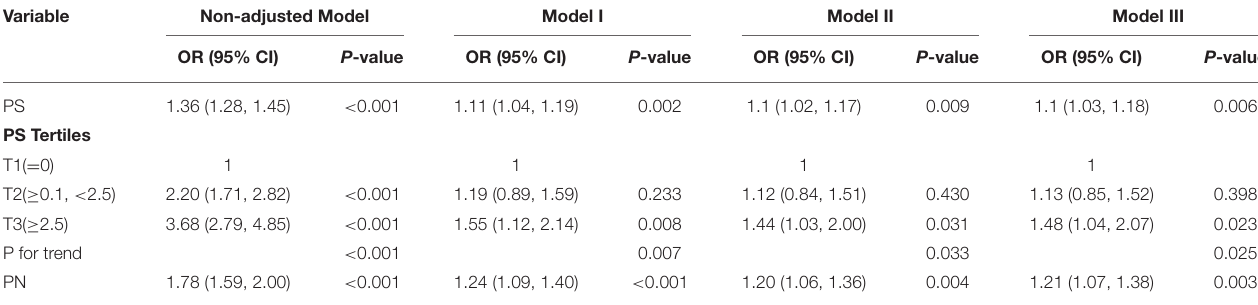
TABLE 2 | Association between PS and incidence of White matter hyperintensity in multiple regression model. Variable Non-adjusted Model Model I Model